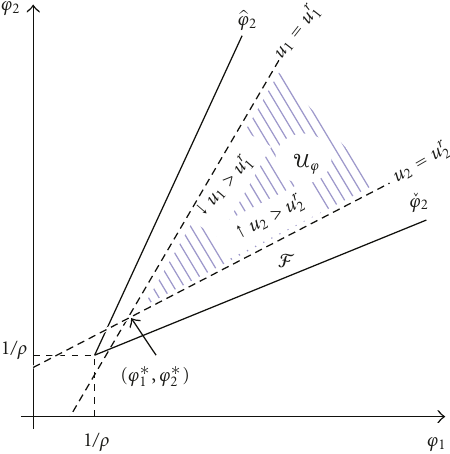
Figure 2: F denotes the region of admissable inverse power prices ( ϕ 1 , ϕ 2 ) whereas U ϕ denotes the region where utility requirements ( u r 1 , u r 2 ) are fulfilled. The optimal inverse power prices ( ϕ ∗ 1 , ϕ ∗ 2 ) is at the bottom tip of U ϕ . See text for more